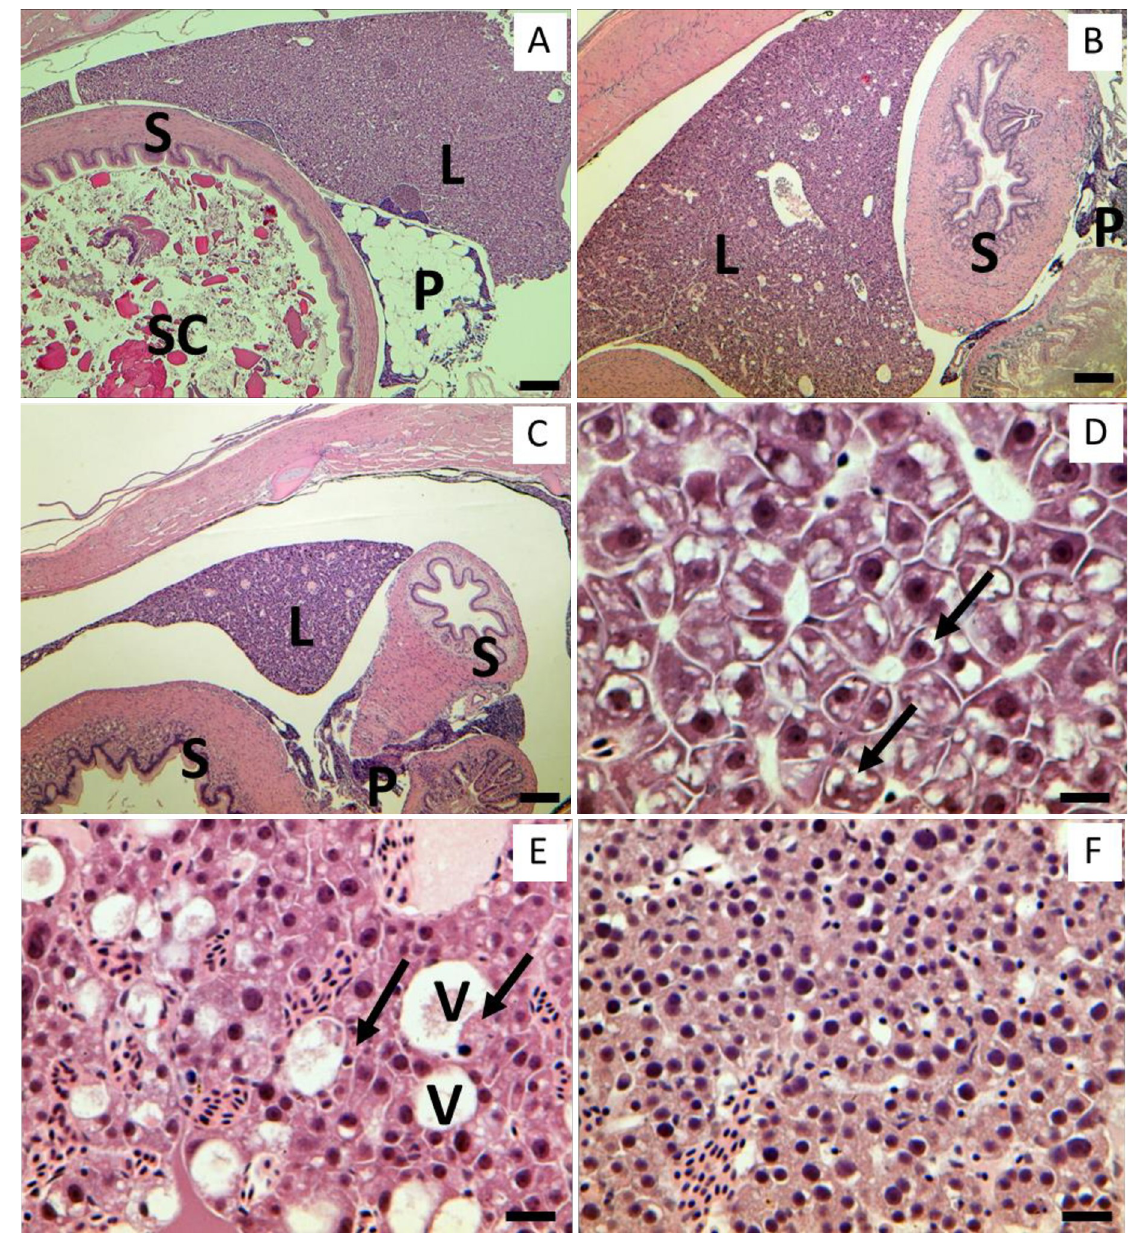
Fig 4. Low (Panels A-C) and high (Panels D-F) magnification starvation progression. Panel A: Delta Smelt transverse section from the Feeding treatment (control), Panel B: Delta Smelt transverse section at Day 21 from the No Feeding treatment, Panel C: Delta Smelt transverse section at Day 49 from the No Feeding treatment. S: stomach, L: liver, SC: stomach contents, P: pancreas. Note atrophy of liver, stomach and pancreas as fasting period lengthens, and empty stomach in panels B and C. Panel D: Liver of Delta Smelt from the Feeding treatment. Arrows indicate glycogen in the cytoplasm of hepatocytes. Panel E: Liver of Delta Smelt at Day 21 from the No Feeding treatment, hydropic vacuolar degeneration (V) with eosinophilic fibrillary material, likely remnants of hepatocytes. Arrows indicate necrotic hepatocytes. Panel F: Liver of Delta Smelt at Day 49 in the No Feeding treatment. Note severely atrophied hepatocytes, loss of cell- to-cell border, basophilia, and crowded nuclei. All panels H&E stained. Scale bars = 150 μ m (Panels A, B and C), 15 μ m (Panels D, E and F).